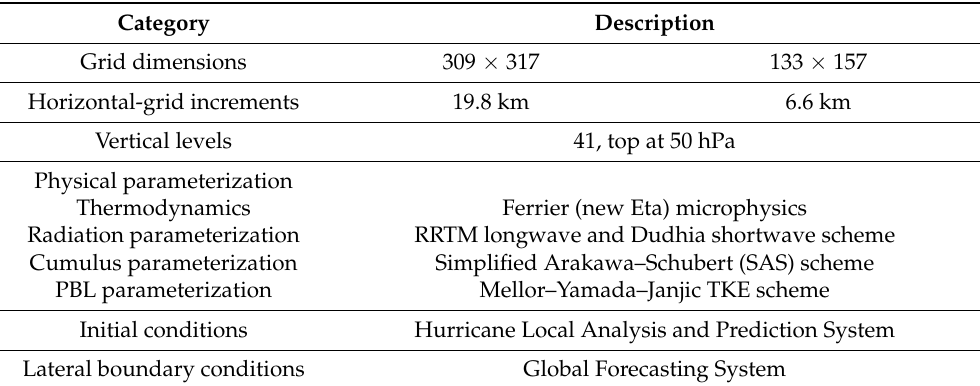
Table 1. Summary of the HRS/HLAPS simulations used in this